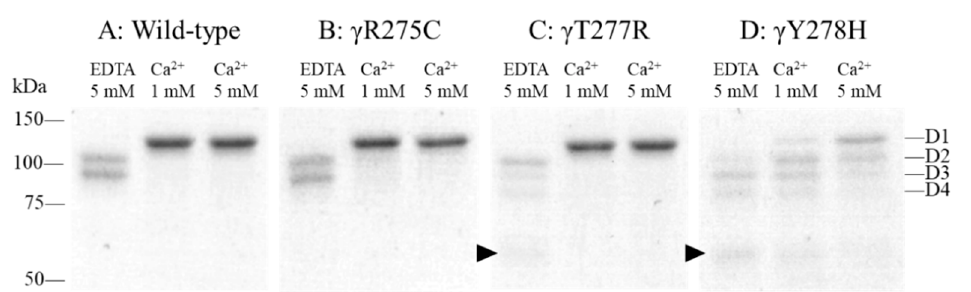
Figure 6. Protection assay for plasmin degradation of fibrinogen. Recombinant fibrinogen (0.30 mg/mL) in HBS buffer containing 5 mM EDTA or 1 or 5 mM Ca 2+ was incubated with 0.18 U/mL plasmin at 37 °C for 2 h. The fragments were analyzed using 10% SDS-PAGE with CBB staining. Fragments D1, D2, D3, and D4 are indicated on the right side of panel D and lower molecular weight fragments are indicated ( ► ). ( A ) wild type, ( B ) γ R275C, ( C ) γ T277R, ( D ) γ Y278H.